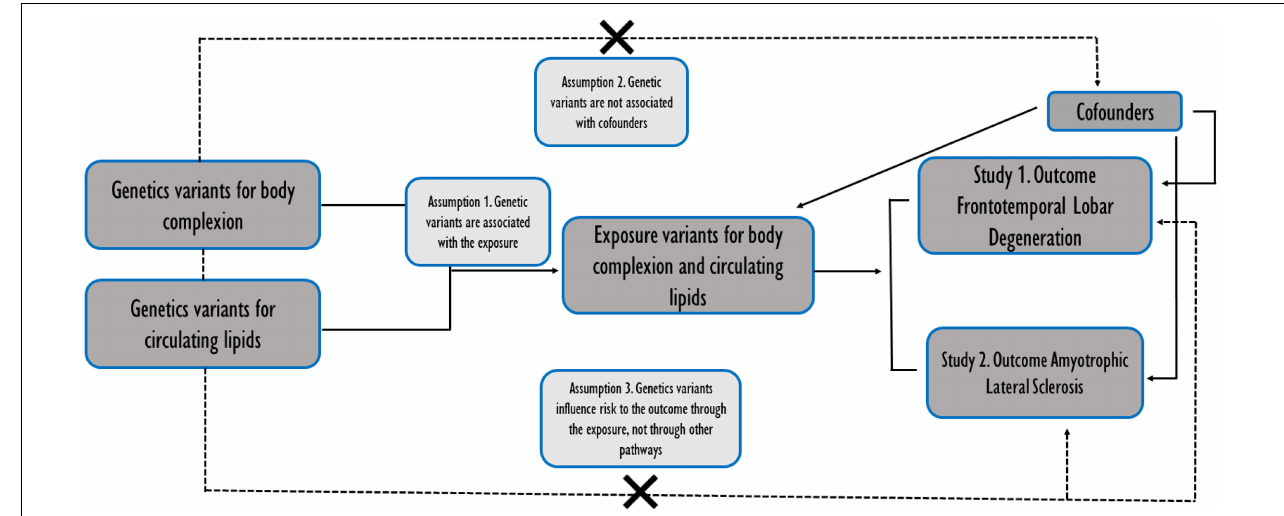
FIGURE 1 | Schematic representation of the two independent studies conducted in parallel. Assumptions of a two-sample Mendelian randomization analyses between the exposures (body complexion and circulating lipids traits) and the outcomes (the risk of frontotemporal dementia TDP43 subtype and amyotrophic lateral sclerosis). Broken lines represent potential pleiotropic or direct causal effects between variables that would violate Mendelian randomization